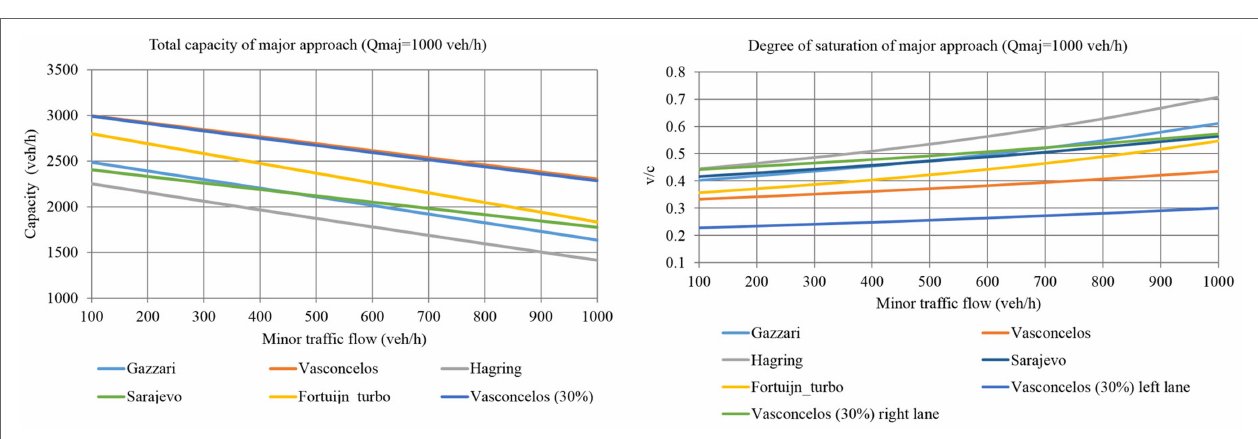
FIGURE 4 | Capacity and v / c curves for scenario A 3 .